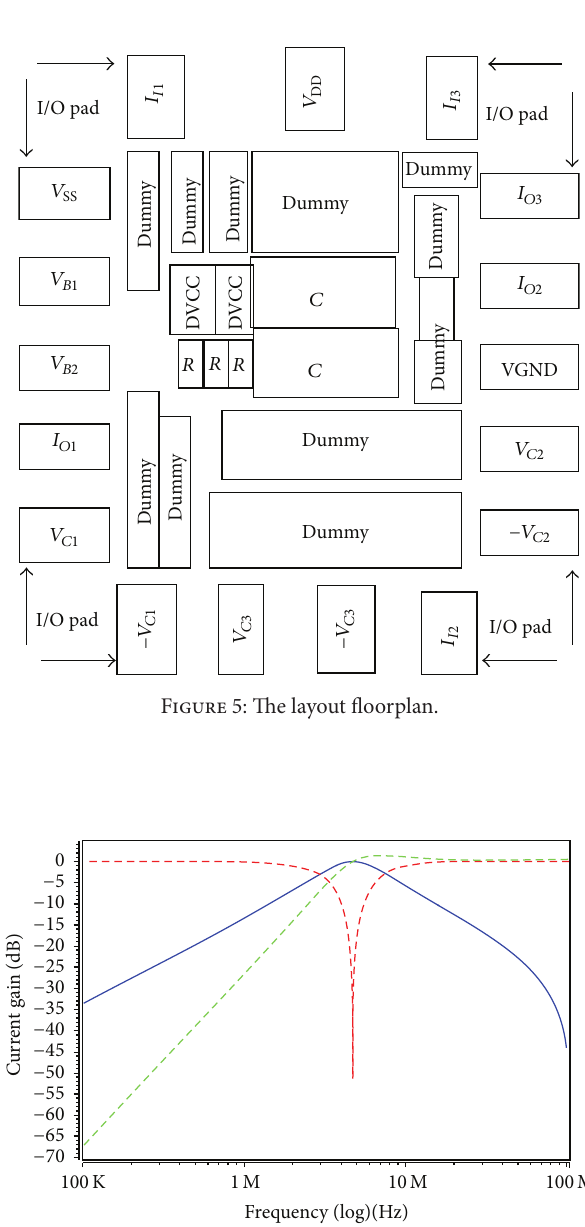
Figure 6: Postlayout simulation responses in Case 1 (highpass response: green; bandpass response: blue; bandreject response: red; = 𝑉 = 𝑉 = 1 and 𝑉 𝐶 𝐶2 𝐶3 1